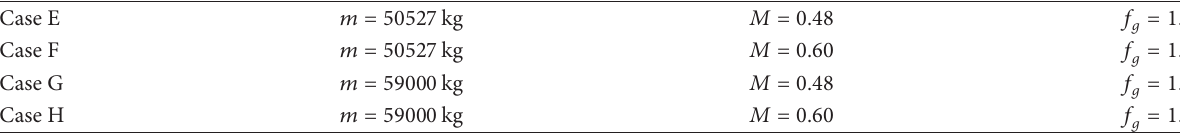
Table 5: Analyzed cases: different mass, flight conditions and gust frequency.